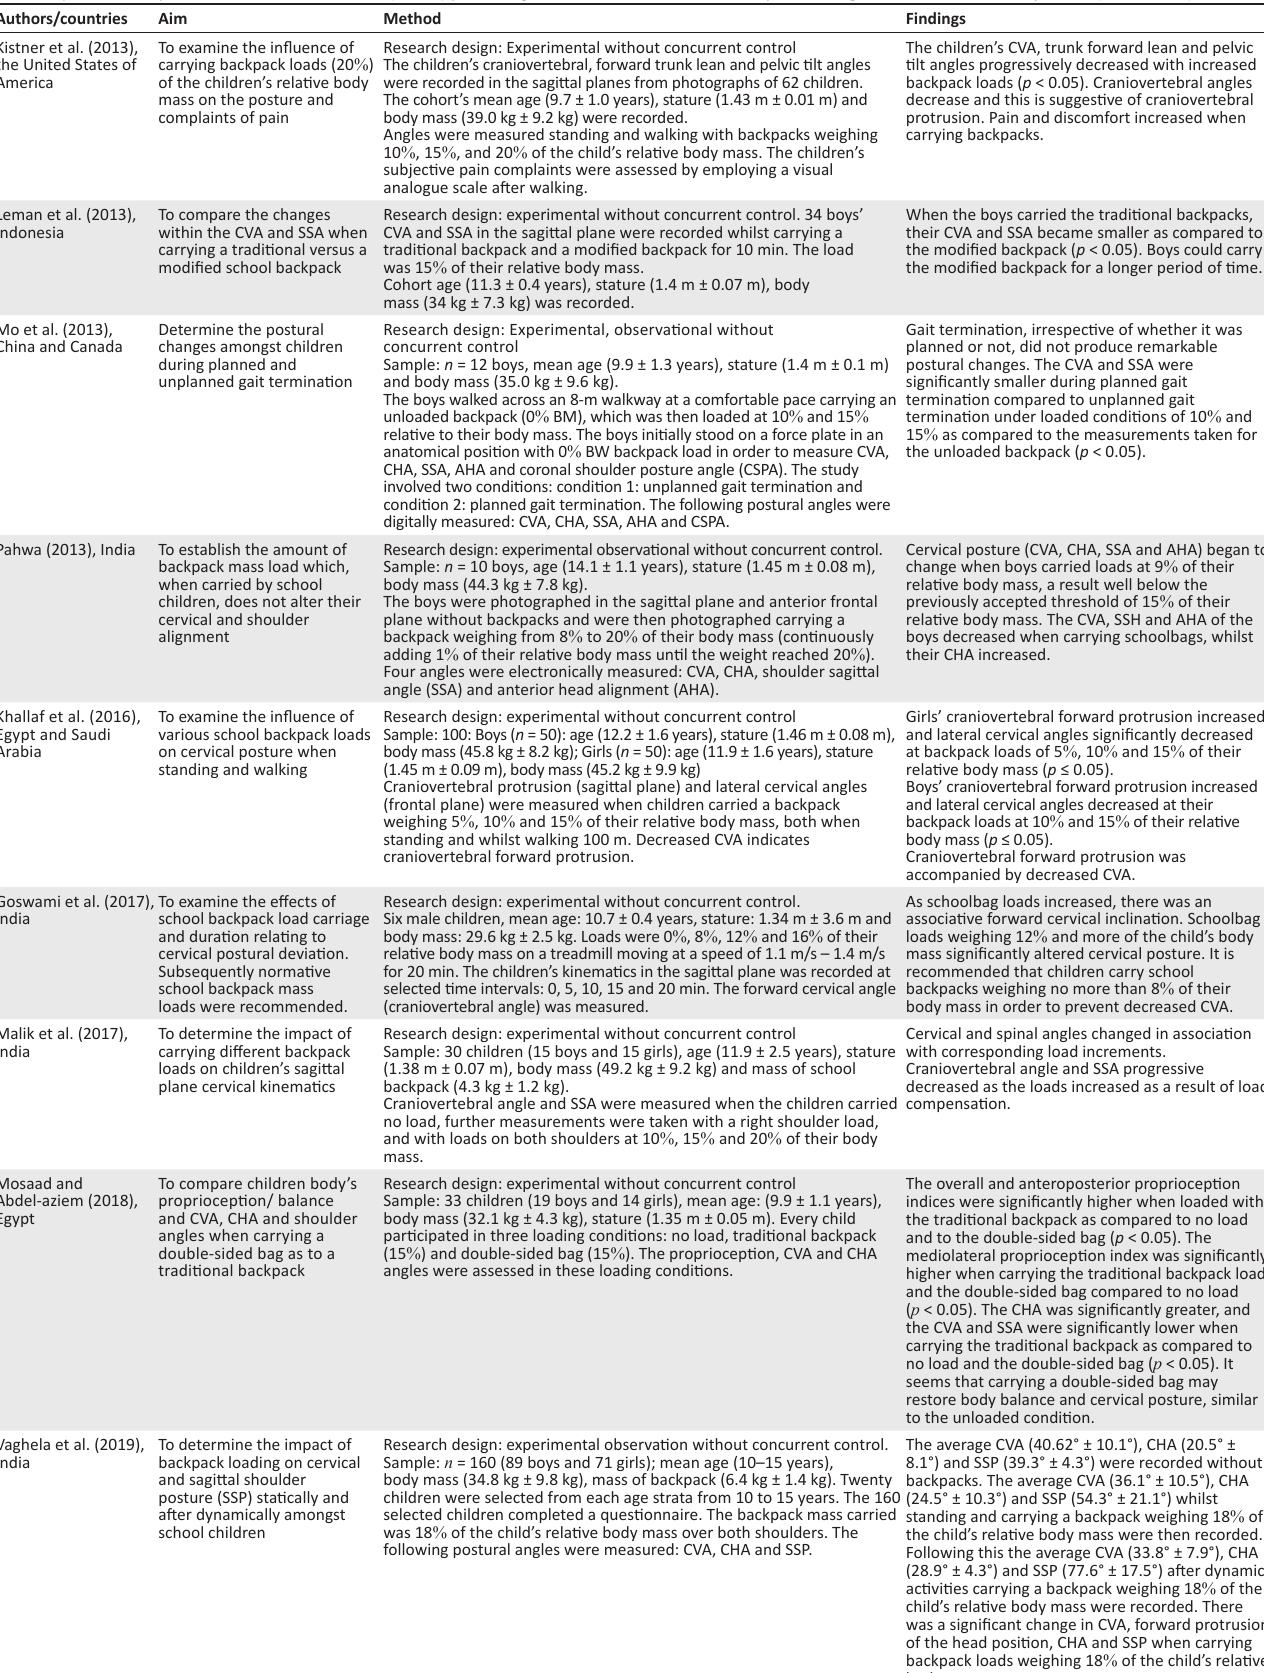
TABLE 2 (Continues...): Results of individual studies ( n = 14) pertaining to the influence of school backpack carriage on children’s cervical posture